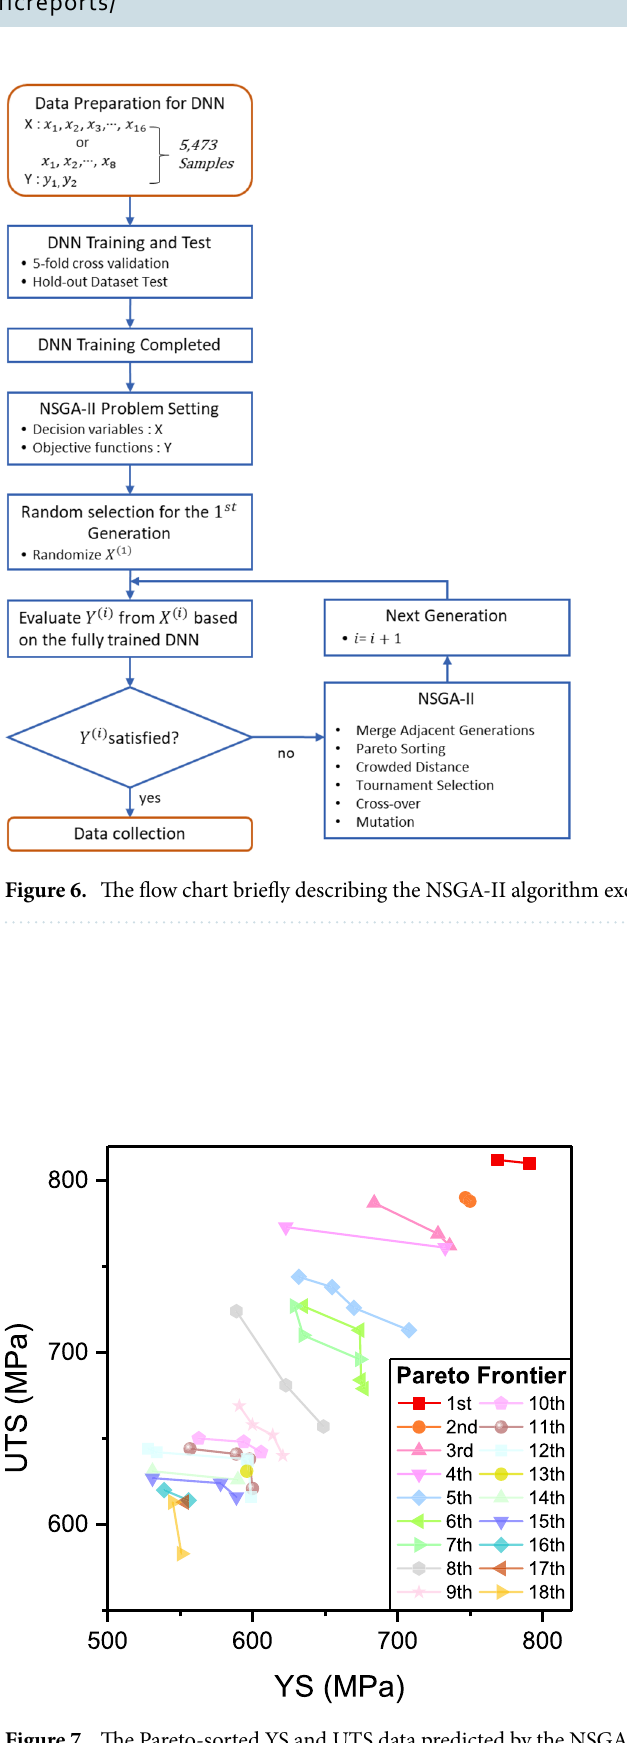
Figure 7. The Pareto-sorted YS and UTS data predicted by the NSGA-II execution. Each Pareto rank is represented in different colors; the first Pareto frontier is in